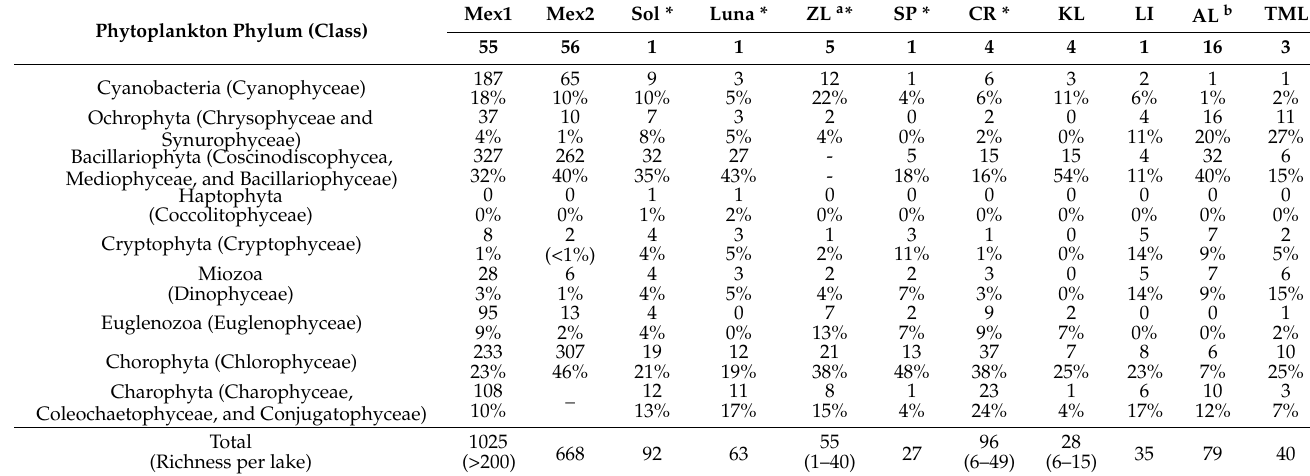
Table 5. Phytoplankton taxonomic richness (S), and percent (%) contribution per phytoplankton group in tropical (*) and temperate HML. (a: diatoms not included, b: includes epilithic diatoms). (Number of water bodies included in the study are below name). (Mex1: Mexico [63]; Mex2: Mexico [70]; Sol: Lake El Sol; Luna: Lake La Luna; ZL: Zempoala lakes, M é xico [71]; SP: Lake San Pablo, Ecuador [19]; CR: Colombian reservoirs [72]; KL: Lake Kolsay, Kazakhstan [73]; LI: Laghetto Inferiore, Switzerland [74]; AL: Adamello-Brenta lakes, Italy [9]; TML: Tatra Mountains lakes, Slovakia